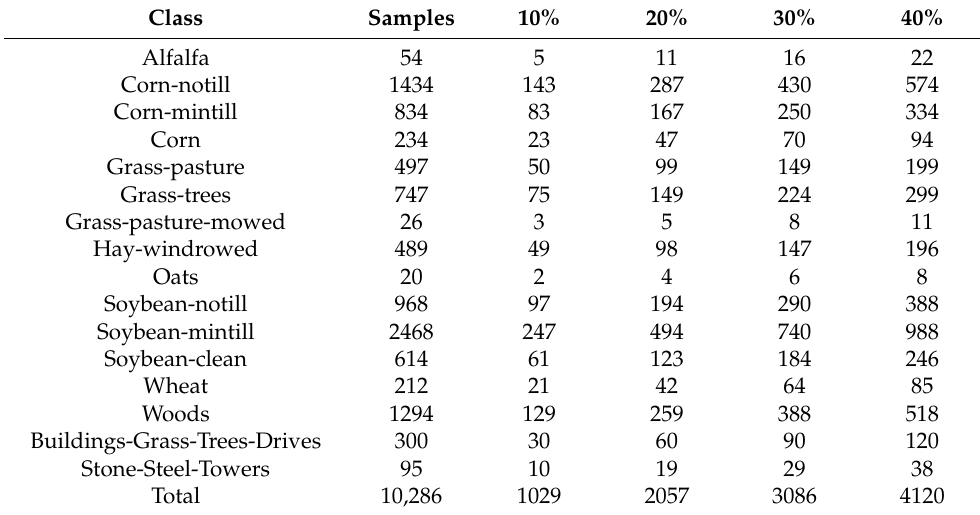
training samples.